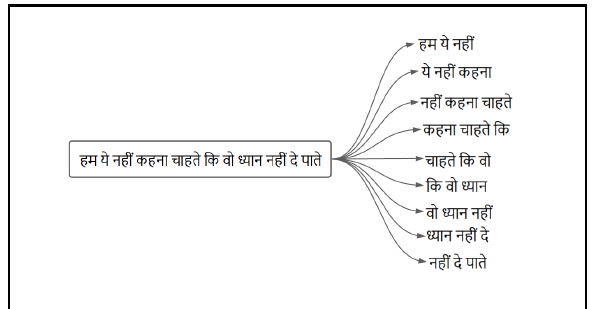
Fig 4.2 Trigram Generation of sentences